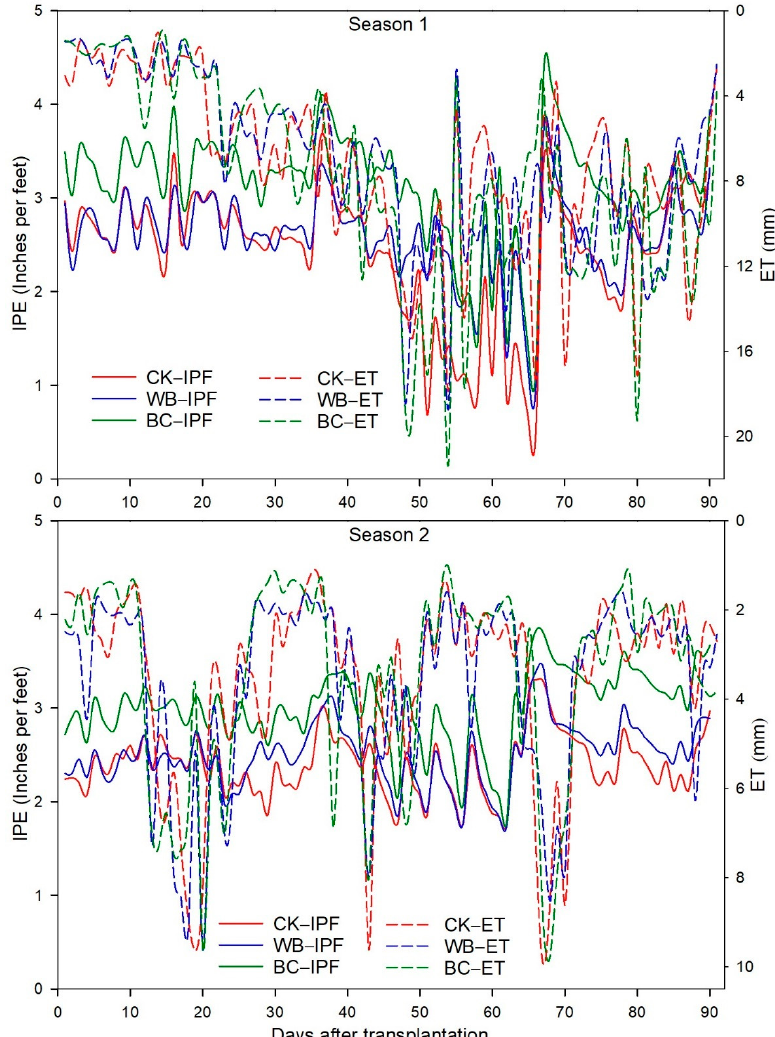
Figure 2. Mean values for IPF and ET for each day in two cropping seasons presenting peak ET in